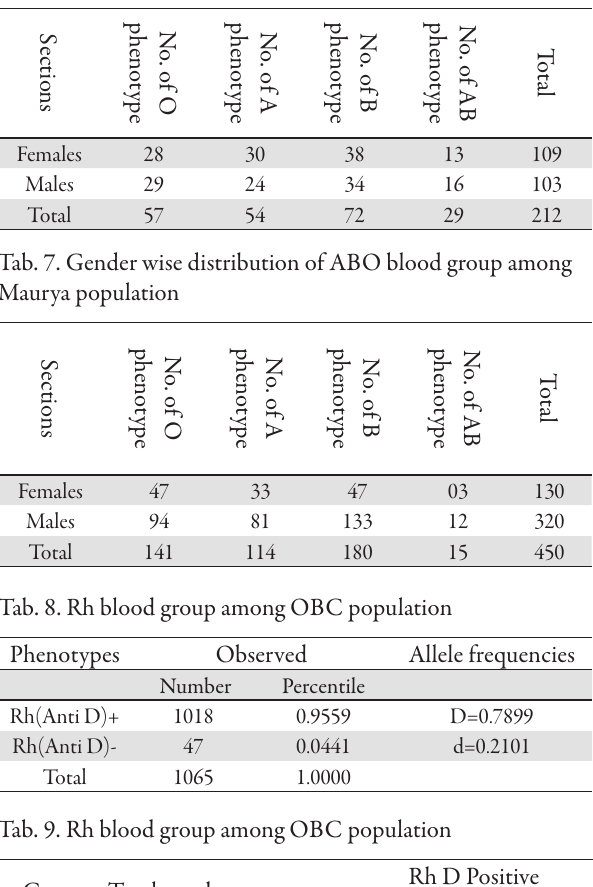
Tab. 6. Gender wise distribution of ABO blood group among Kurmi population